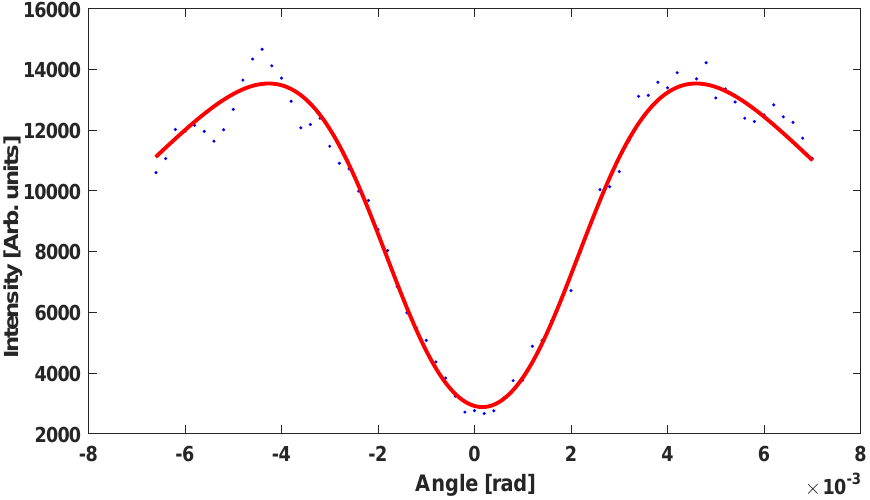
Figure 11. Fit of the experimental data by using the Equation (2). The line profile represents the angular distribution from one of the microlens